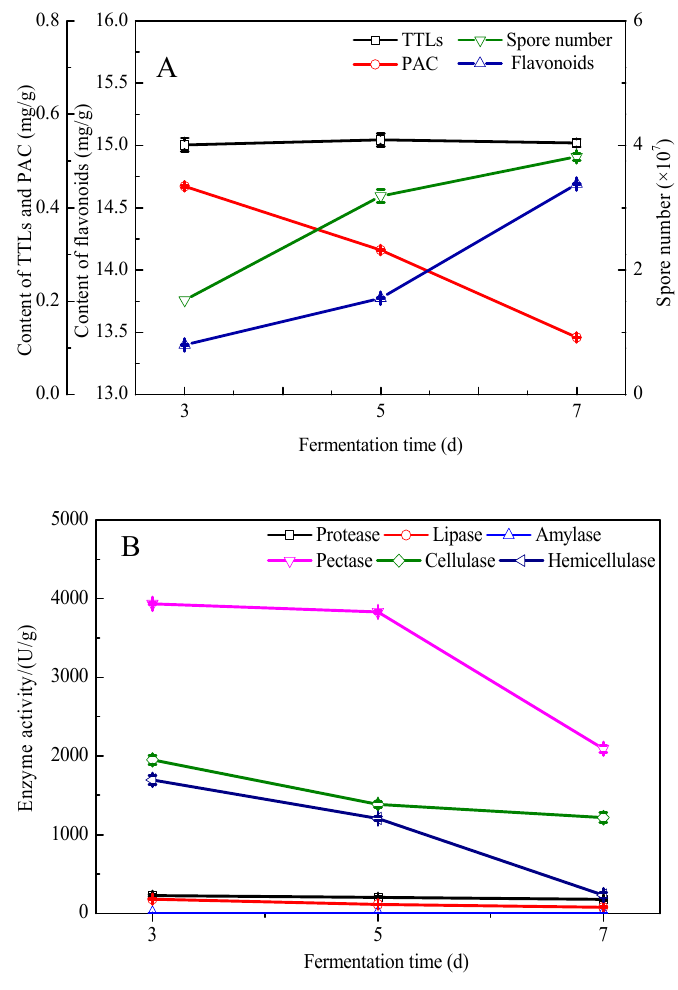
Figure 1. Changes of different indexes: ( A ) spore number, terpene trilactones (TTLs), procyanidine (PAC), and flavonoids; and ( B ) activities of different enzymes during the prefermentation of pure G. biloba leaf powder with Eurotium cristatum.